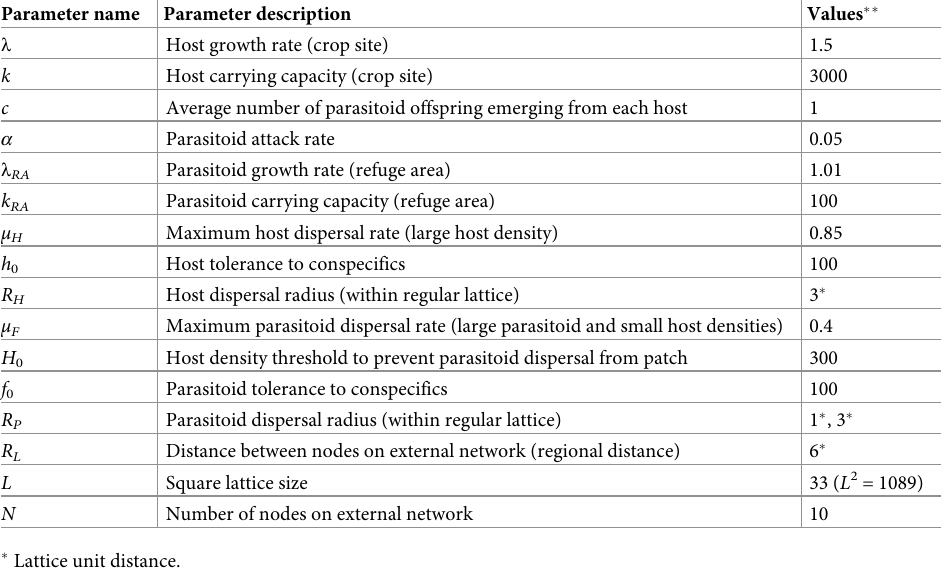
Table 1. Parameter values for the spatially-explicit simulation